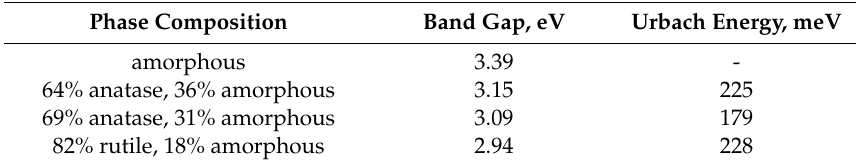
Table 2. Phase composition, optical band gap, and Urbach energy of amorphous, predominantly anatase, and predominantly rutile